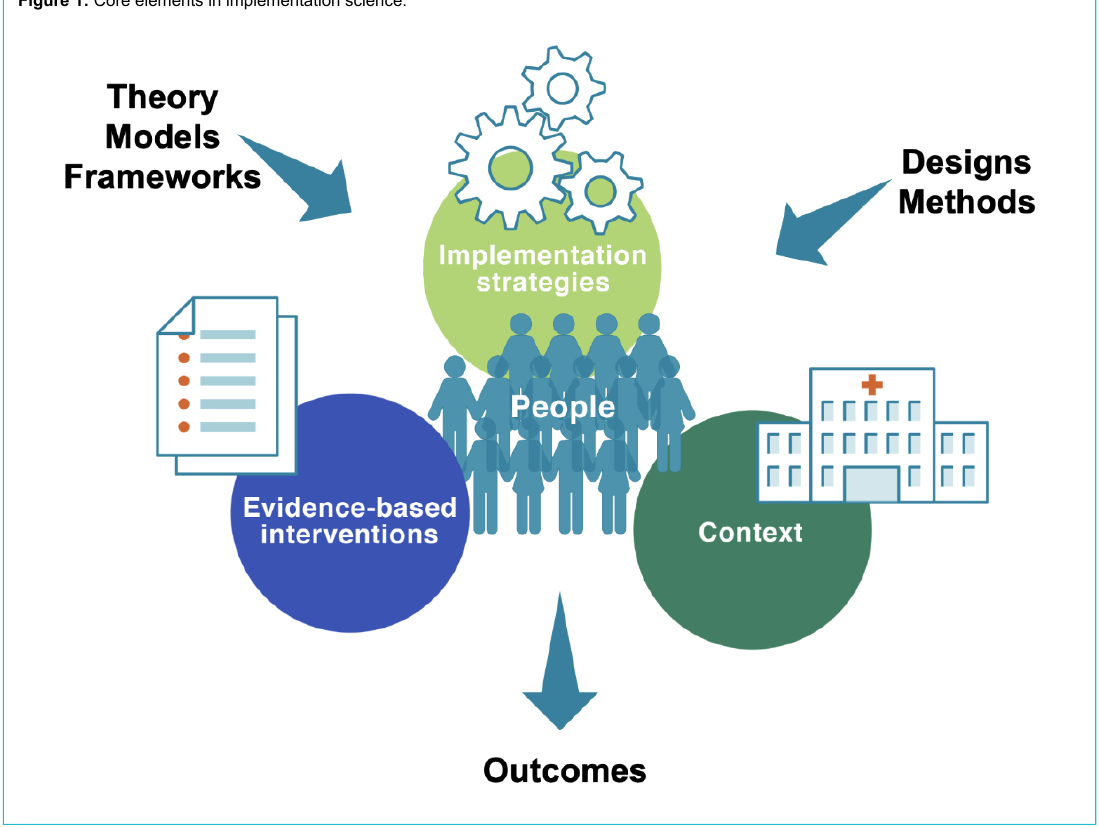
Figure 1: Core elements in implementation